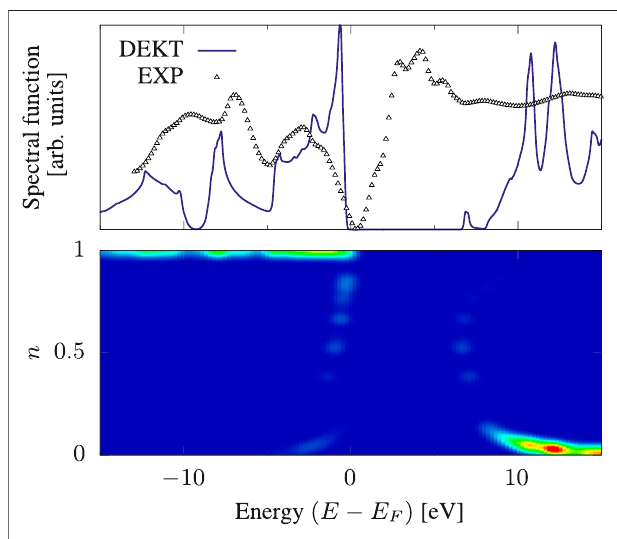
FIGURE2| SpectralfunctionofbulkSiwithinDEKT(violetsolidline).The experimental photoemission spectrum (small triangles) is taken from Ref. (Chelikowsky et al., 1989). The color map illustrates the occupation numbers n i that play a role into the spectrum for the reported energy